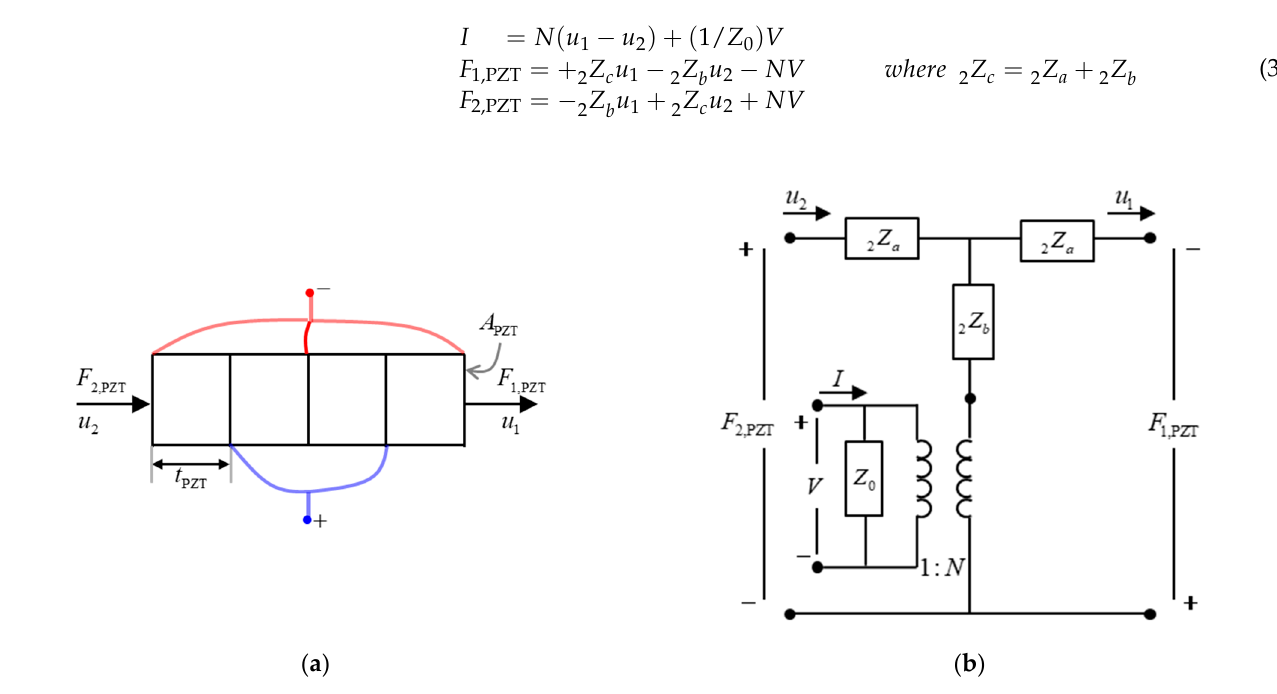
Figure 2. Piezoelectric stack in the 33 mode: ( a ) Free body diagram. ( b ) Equivalent circuit (EC) model. Using Equation (3), the following equations can be